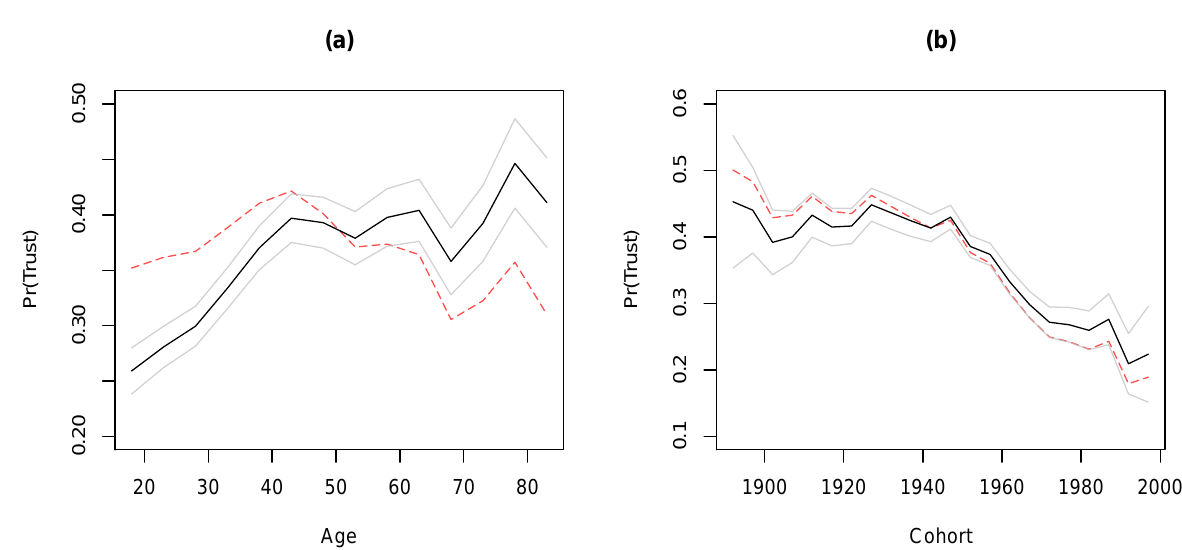
Figure 14: Synchronic age and cohort curves. Notes: (a) displays the synchronic age curve with an estimated slope of θ 1 − θ 2 = 0.485. Overlaid red dashed line denotes the diachronic age curve with an estimated slope of θ 1 = − 0.192. (b) displays the synchronic cohort curve with an estimated slope of θ 2 − θ 1 = − 0.485. Overlaid red dashed line denotes the diachronic cohort curve with an estimated slope of θ 2 = − 0.677. Estimates are based on age and cohort synchronic L-APC logistic regression models, respectively. Outcome is social trust, coded so that 1 = “can trust” while 0 = “can’t be too careful” or “depends.” Results adjusted using sampling